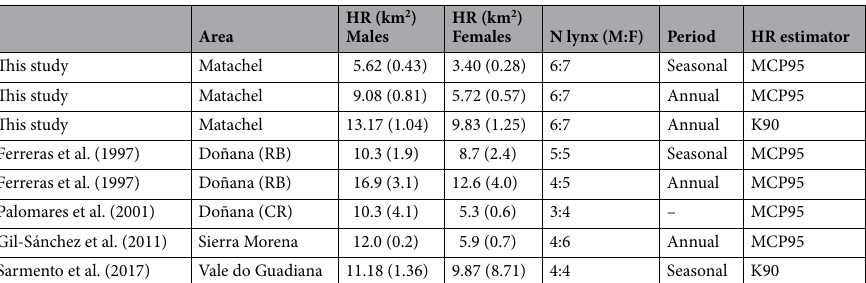
Table 2. Iberian lynx territory size: the results of the analyses in this study and in other populations using VHF telemetry. RB Reserva Biológica subpopulation, CR Coto del Rey subpopulation. The values of home range are presented as mean